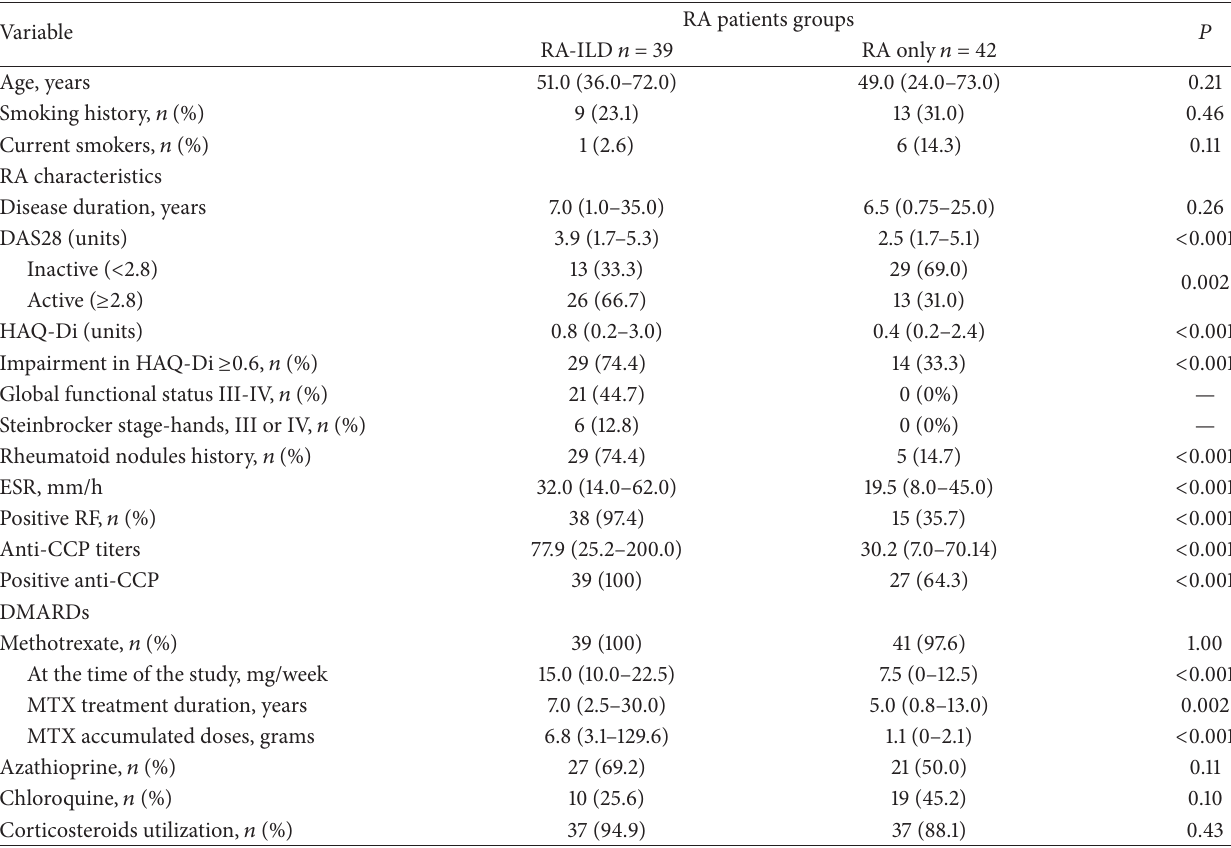
Table 1: Comparison in selected clinical variables between patients with RA and interstitial lung disease (RA-ILD) and patients with RA without interstitial lung disease (RA